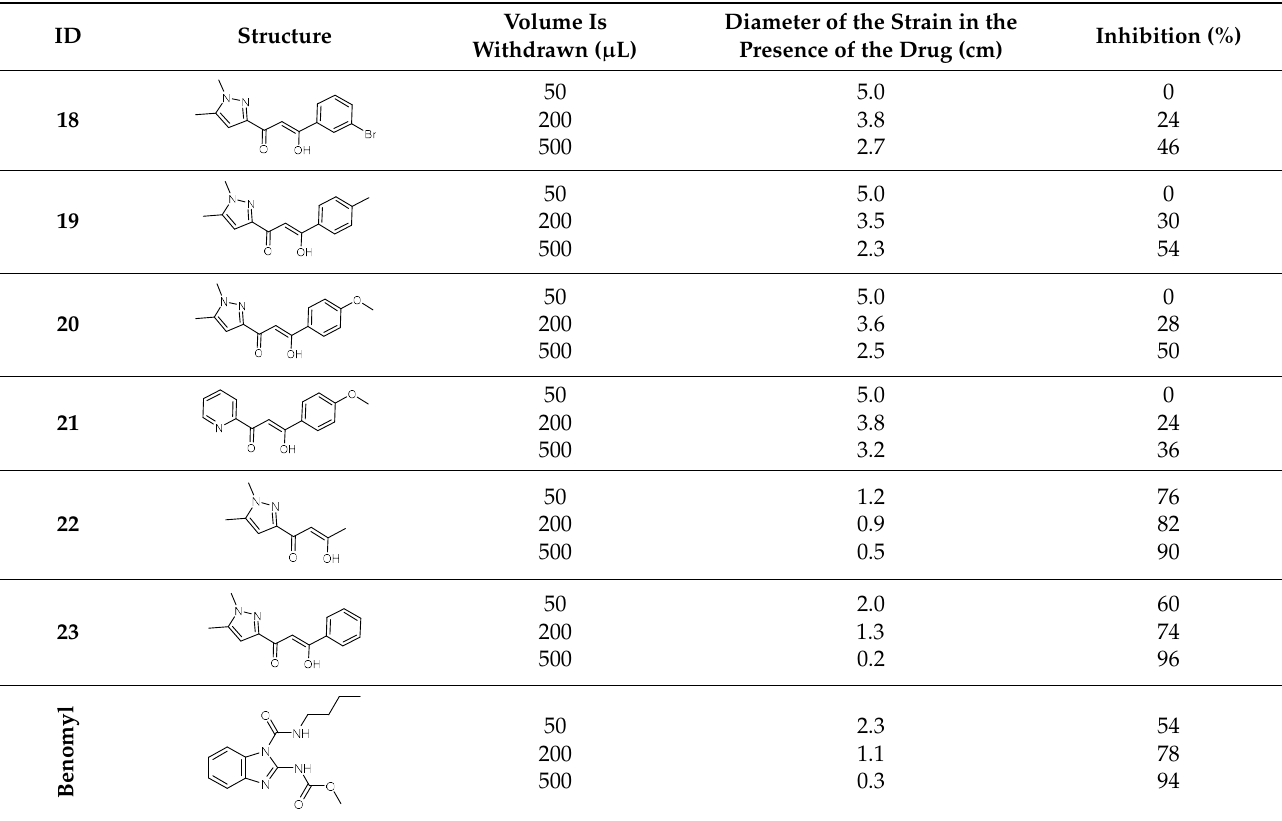
Table 3. Volume is withdrawn, a diameter of the strain and inhibition percentages of the tested (Z)-3(3-bromophenyl)-1-(1,5-dimethyl-1 H -pyrazole-3yl)-3-hydroxyprop-2-en-1-one derivatives 18 – 23 against F.o.a. Volume Is Withdrawn ( µ L)